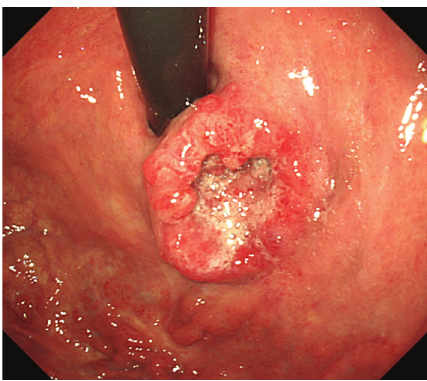
Figure 1: Upper endoscopic examination revealed a localized ulcerative lesion (diameter, 4cm) located on the lesser curvature of the upper stomach.